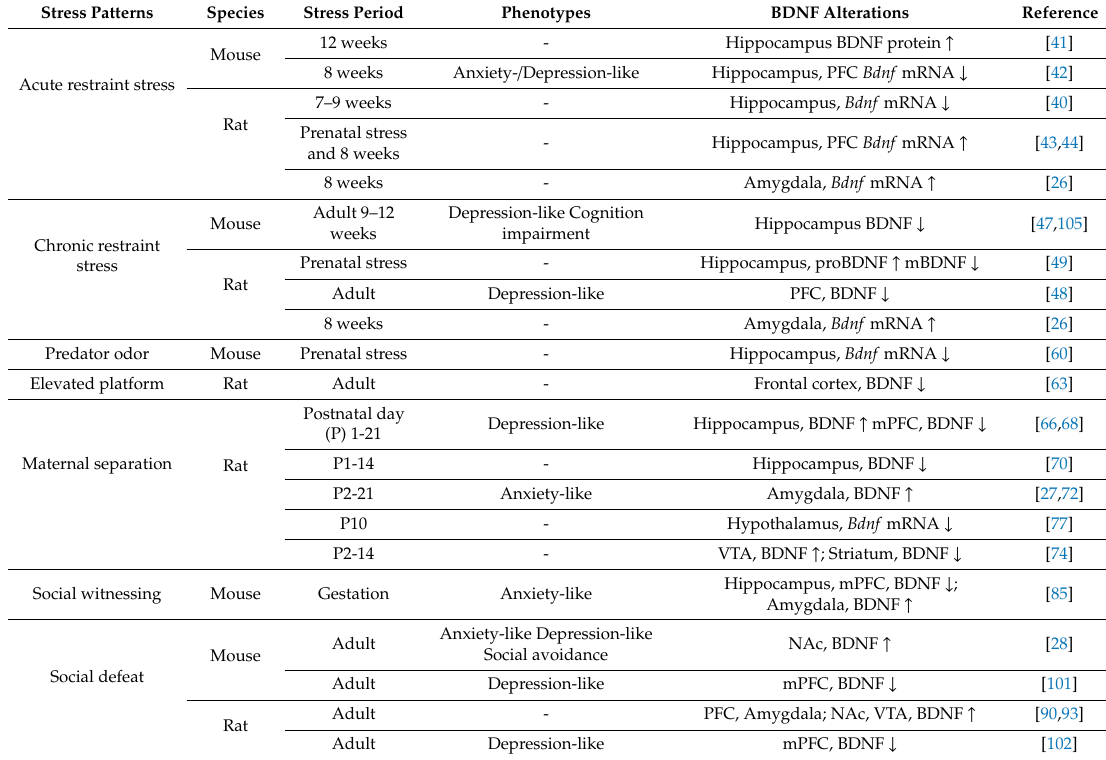
Table 1. Summary of the e ff ects of distinct stressors on brain-derived neurotrophic factor (BDNF). Stress